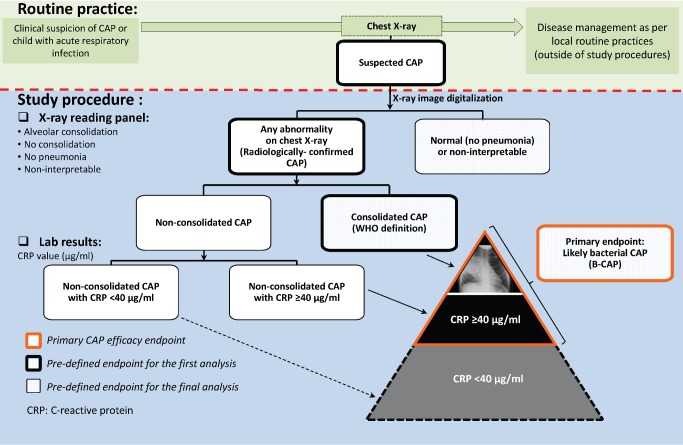
Chest X-ray classification and CAP end point definitions.